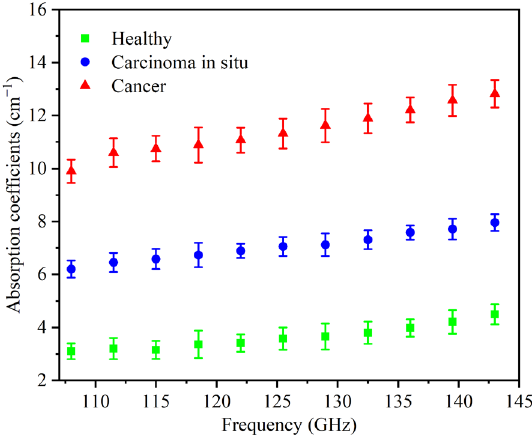
Figure 3. The average absorption coefficient spectra of healthy tissues (green), carcinoma in situ tissues (blue), and cancer tissues (red).